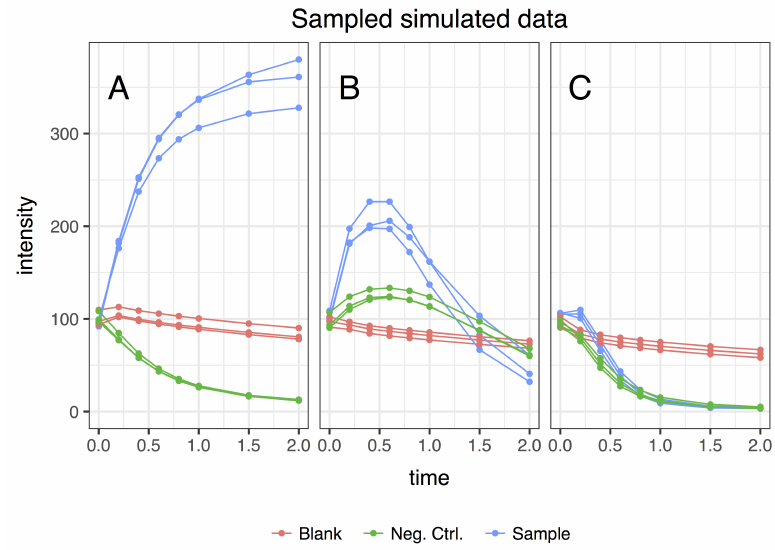
Figure 5. Example of time dynamics in a simulated metabolic network. ( left ) Example of an influx receiving network (between time 0.0 and 0.5); ( right ) the same network without external influx. Each line is a single metabolite (node in the network); a red line in the left plot indicates a metabolite (node) that receives an influx, whereas this metabolite does not receive an influx in the right plot. A single metabolic network underlies both plots. The network was initiated with the same starting parameters in each case (fixed starting concentration with Gaussian noise). The inclusion of an external influx results in different dynamics and in a different end state. Note that the units on the time axis correspond to the time units of the system of differential equations. In a way, these are arbitrary as the time scale of the dynamics depend on how the system is set up. Lower enzymatic concentrations will result in slower dynamics and vice versa.